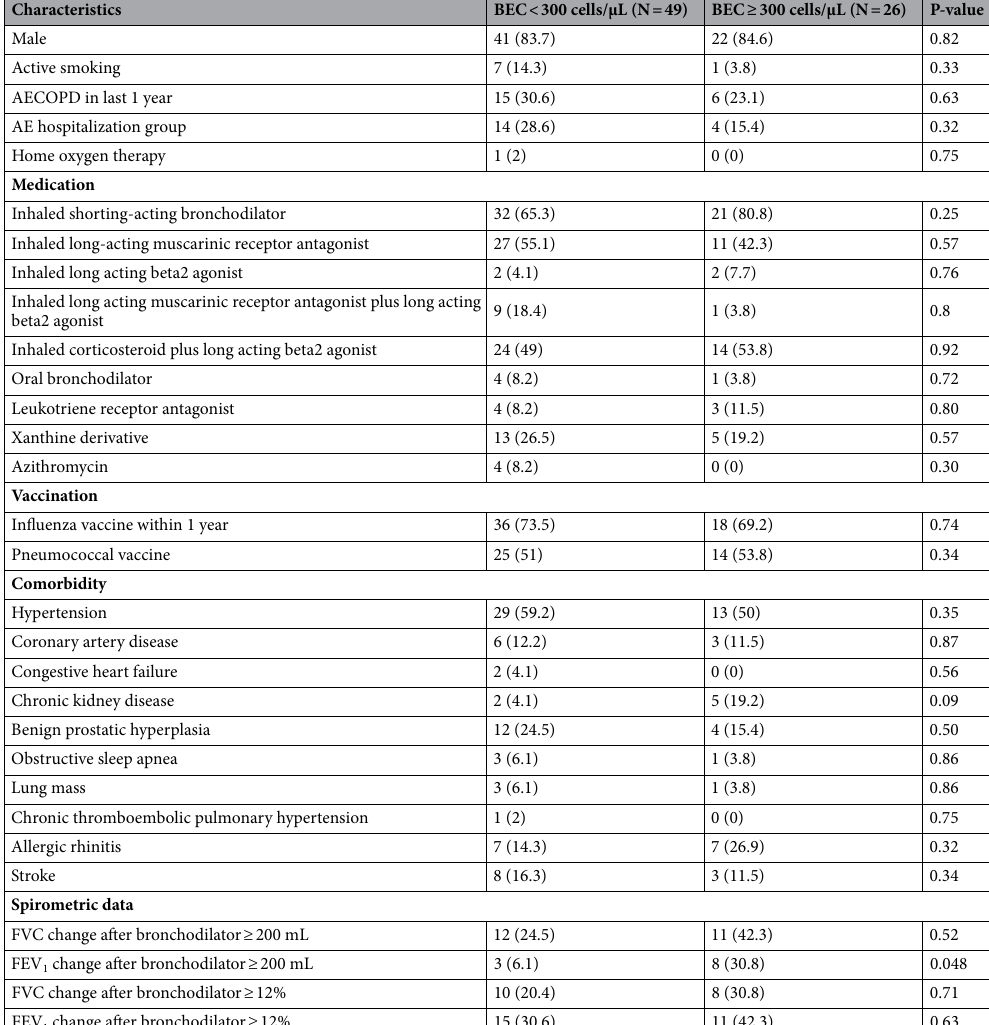
Table 3. Characteristics of COPD patients with or without blood eosinophil count ≥ 300 cells/µL. Data shown as n (%). FVC forced vital capacity, L liter, FEV 1 forced expiratory volume in 1 s, AECOPD acute exacerbation of chronic obstructive pulmonary